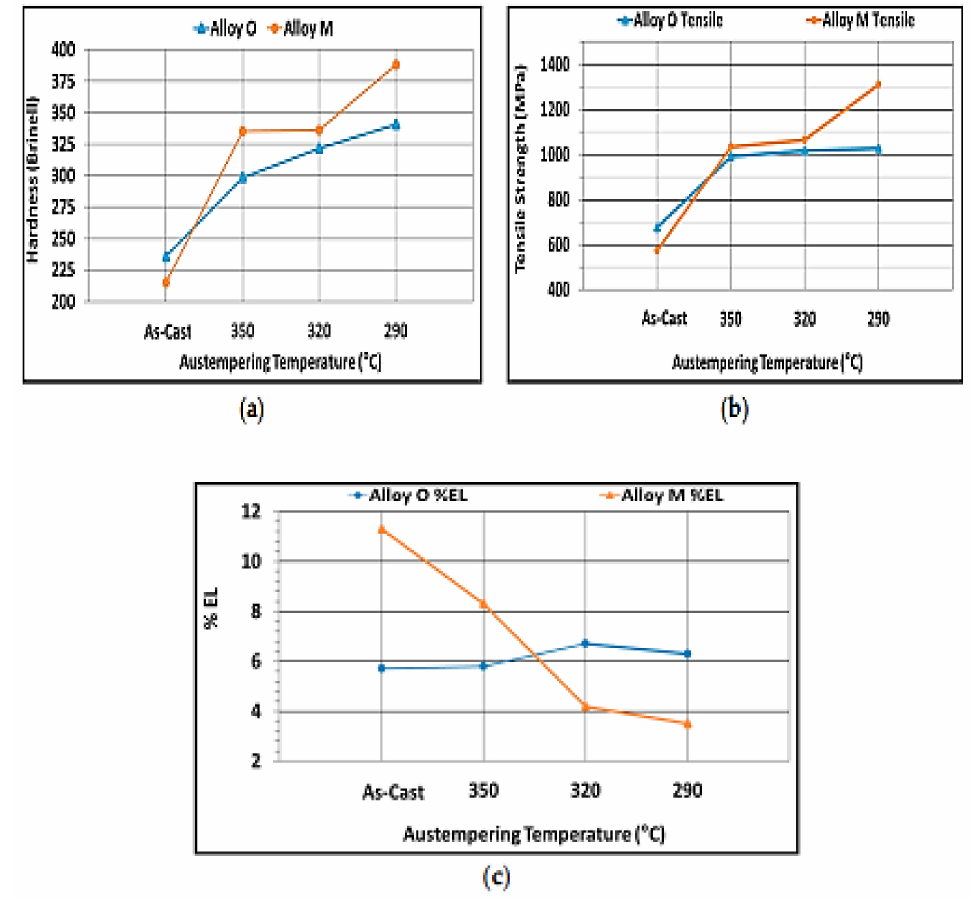
Figure 42. The outcomes of the mechanical properties of the as-cast and austempered specimens [56]. ( a ) Hardness ( b ) Tensile strength, ( c ) Percentage elongation. Eraslan et al. (2021) [50] also observed the increase in subsurface hardness under conventional cutting fluid for austempered ductile iron and cast steel compared to dry and minimum-quantity lubrication states (Figure 43).